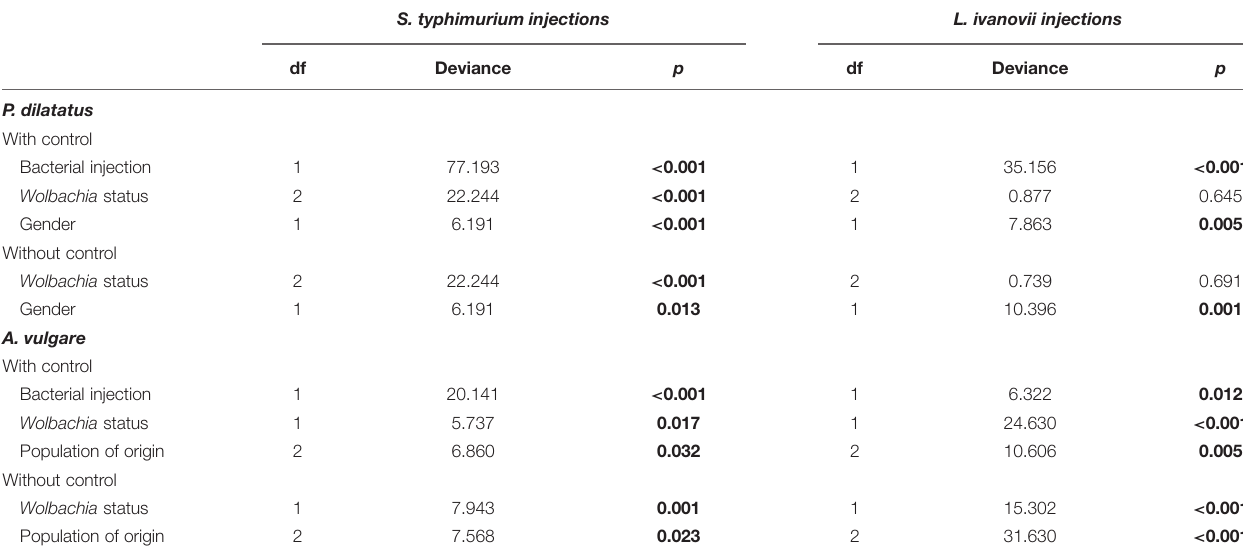
( Table 2 ): both L. ivanovii and S. typhimurium were pathogenic for both isopod host species. The presence or absence